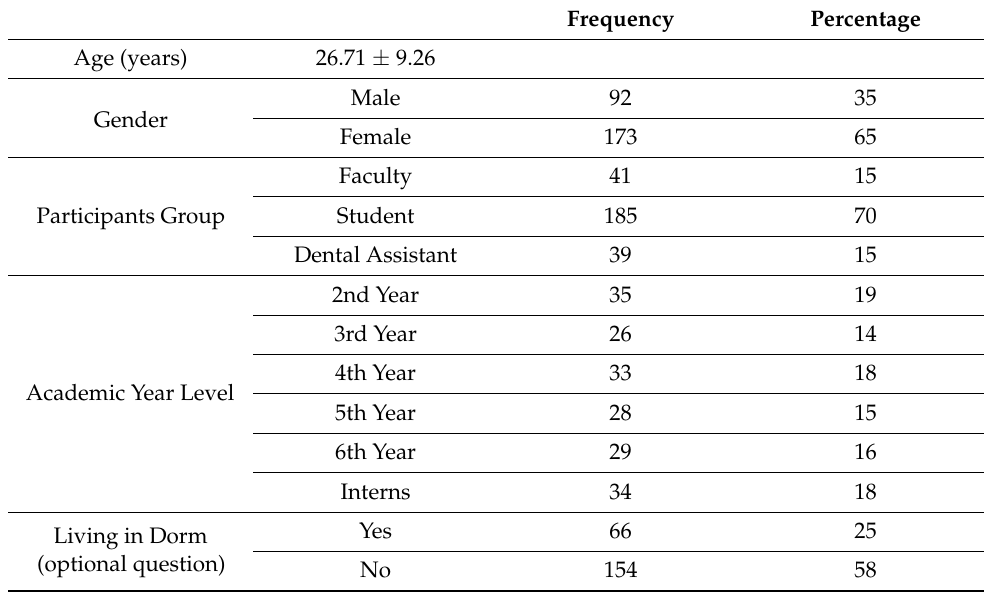
Table 1. Showing demographics of the participants in our